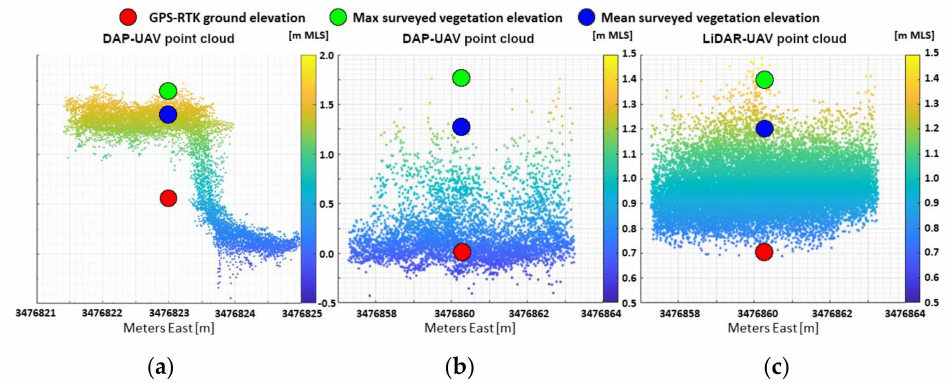
Figure 6. Visual comparison between the vertical distribution of a portion of the Digital Aerial Photogrammetry (DAP)-UAV ( a,b ) and the LiDAR-UAV ( c ) point clouds. ( b ) and ( c ) refer to the same survey point located on the marsh platform. The red dot represents the surveyed GPS-RTK ground elevation. The green and blue dots represent the maximum and mean vegetation height surveyed in the considered